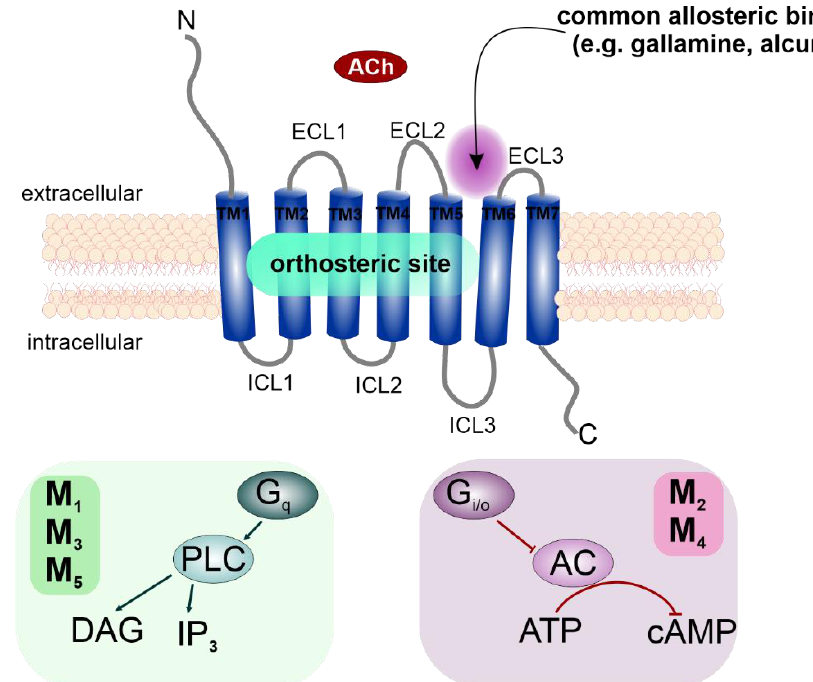
Figure 1. Schematic structure of mAChRs and their preferential signaling pathways. Classical allosteric modulators of mAChRs, such as gallamine or alcuronium, bind to the extracellular part of the receptor between ECL2 and ECL3 [8]. Ach — acetylcholine; ECL — extracellular loop; TM — trans- membrane α -helix; ICL — intracellular loop; DAG — diacylglycerol; IP 3 — inositol triphosphate; AC — adenylyl cyclase; PLC — phospholipase A.